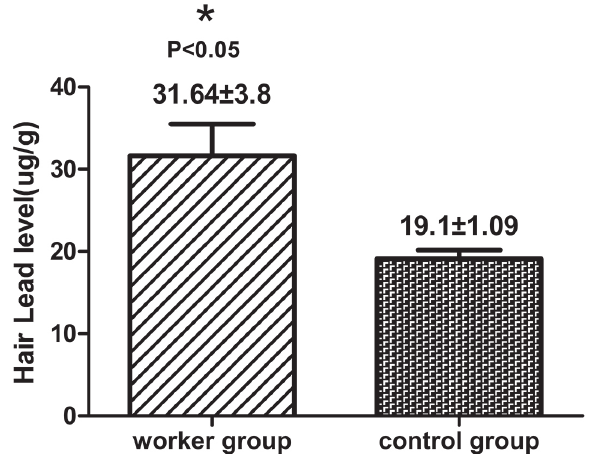
FIGURE 1 - Pb concentrations in hair of workers in different oil companies. Values were expressed as mean±SD; * represents a significant difference with P>0.01.